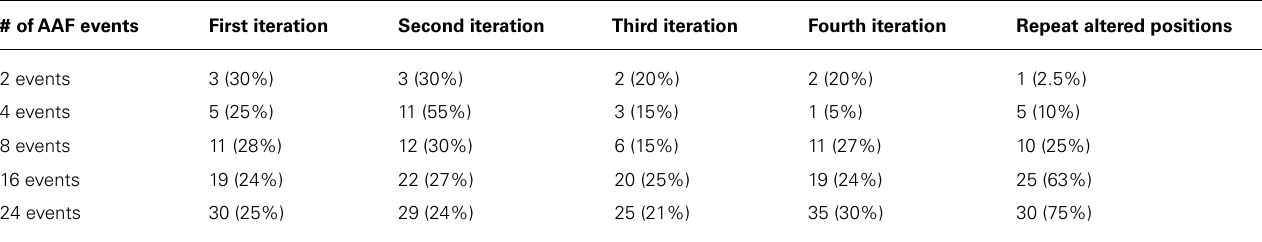
Table 2 | Distribution of altered events by position in the sequence, summed across the five parameter files for each condition. # ofAAF events